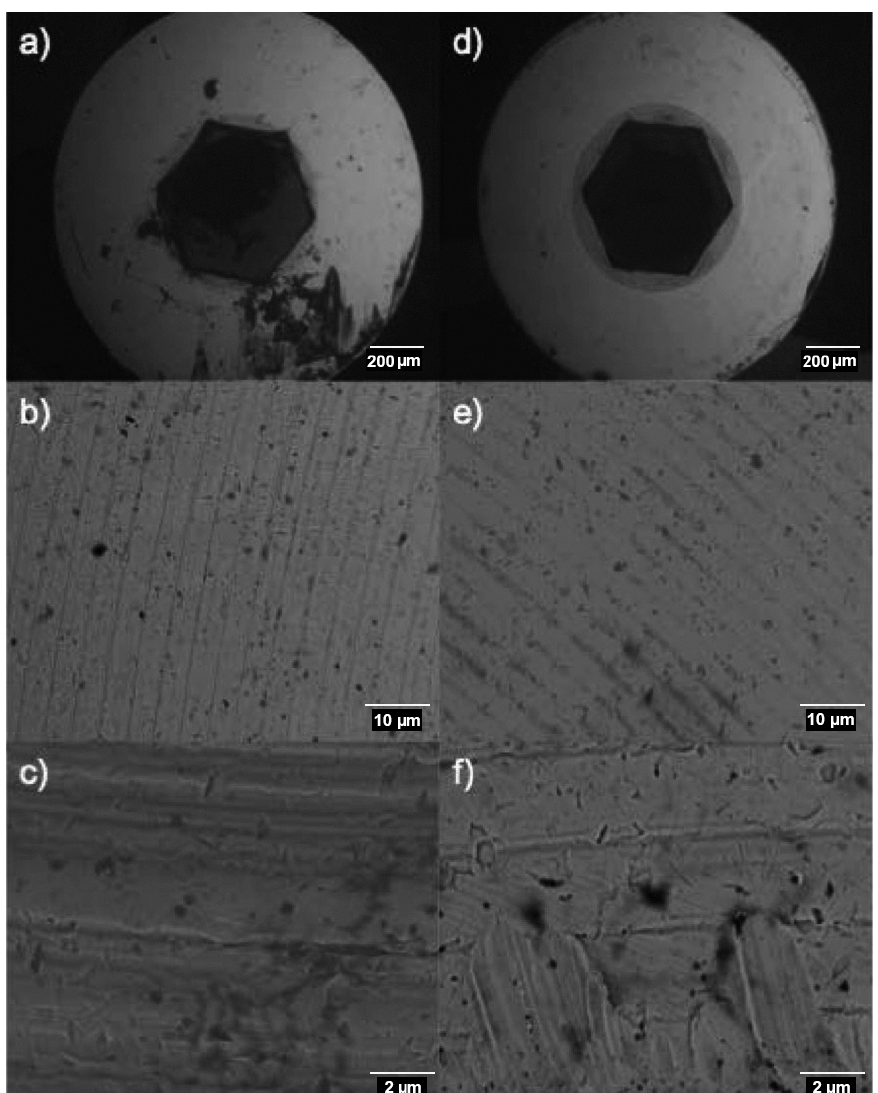
Figure 5. SEM. study of the cranial surface of the screws belonging to the control group ( a – c ) and treated with carboxylphosphonic acid ( d – f ); ( a , d ) 50×; ( b , e ) 1000×; ( c , f ) 3000×.